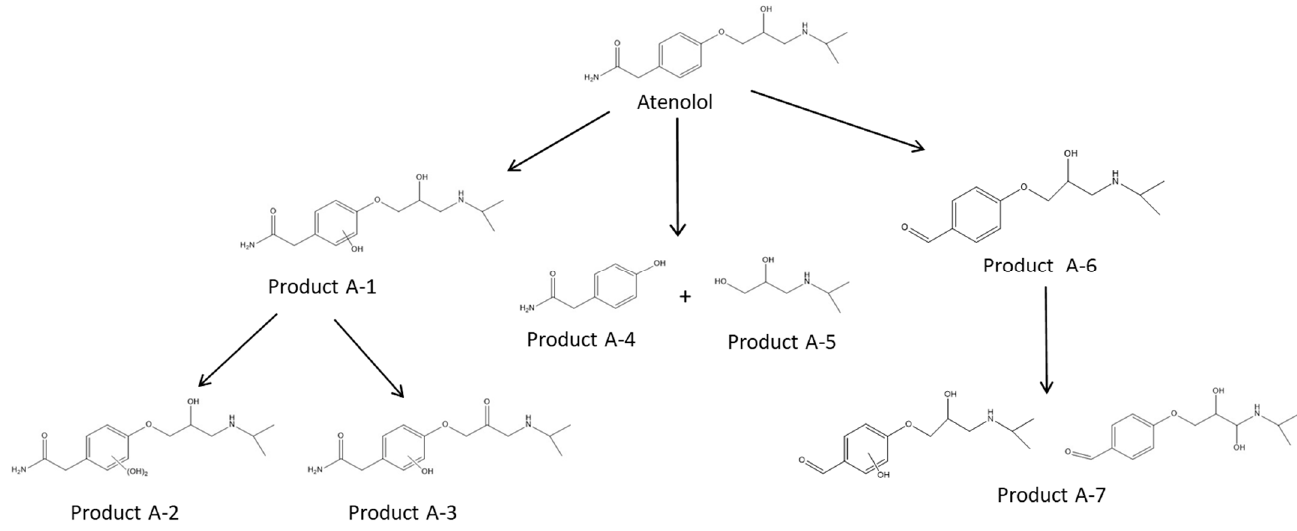
Figure 16. Proposed mechanism for the degradation of ATL.